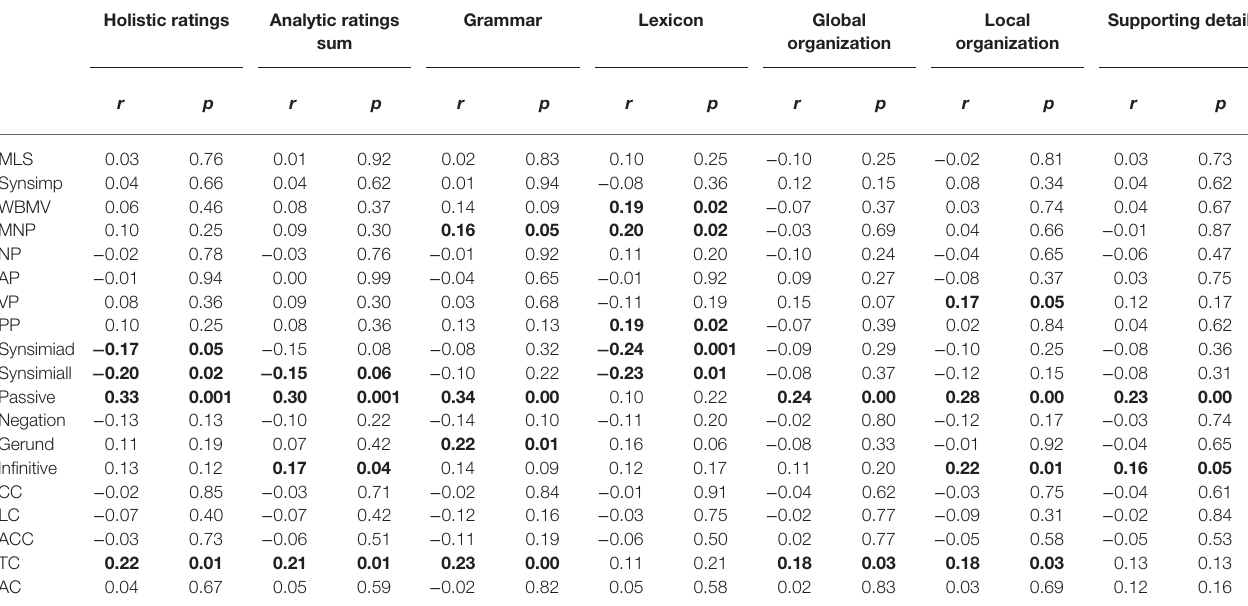
TABLE 3 | Correlation between indices of linguistic features and human ratings.